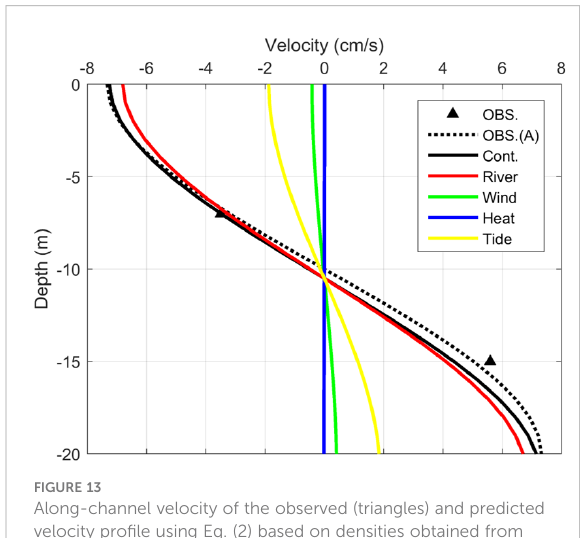
FIGURE 13 Along-channel velocity of the observed (triangles) and predicted velocity pro fi le using Eq. (2) based on densities obtained from observations (dotted black line) and the control (solid black line), river (solid red line), wind (solid green line), heat (solid blue line), and tide experiments (solid yellow